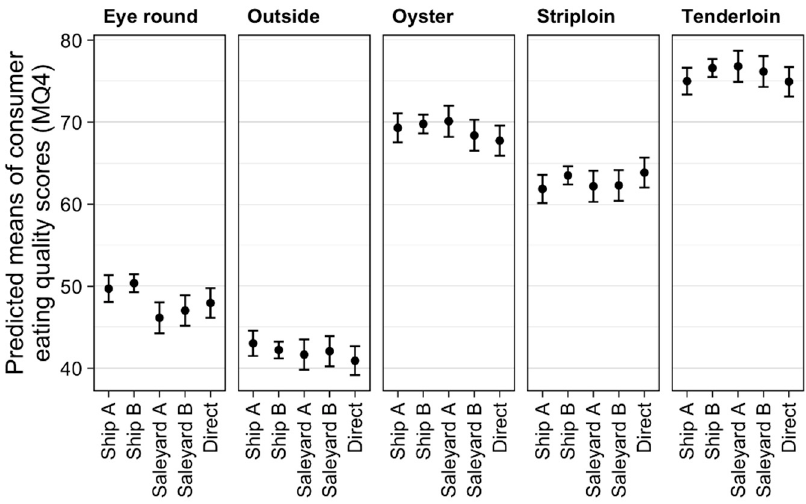
Figure 2. Effect of transport treatment on individual muscle eating quality. The plots show predicted means with 95% confidence intervals where the results are averaged over the levels of sex, aging, mixing method, and resting.